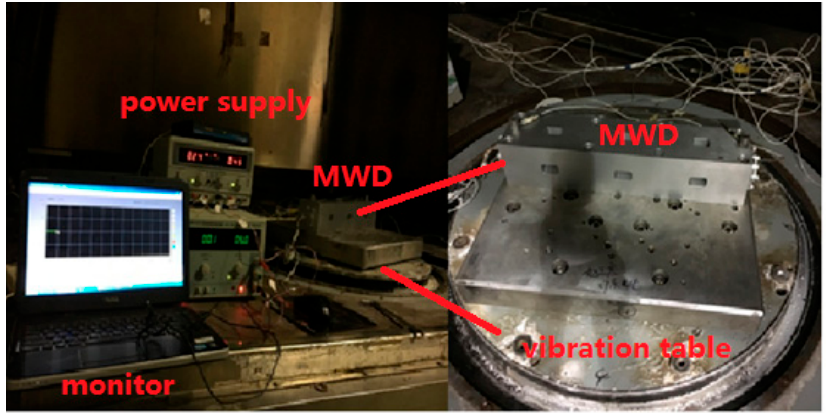
Figure 1. Vibration experiment setup.